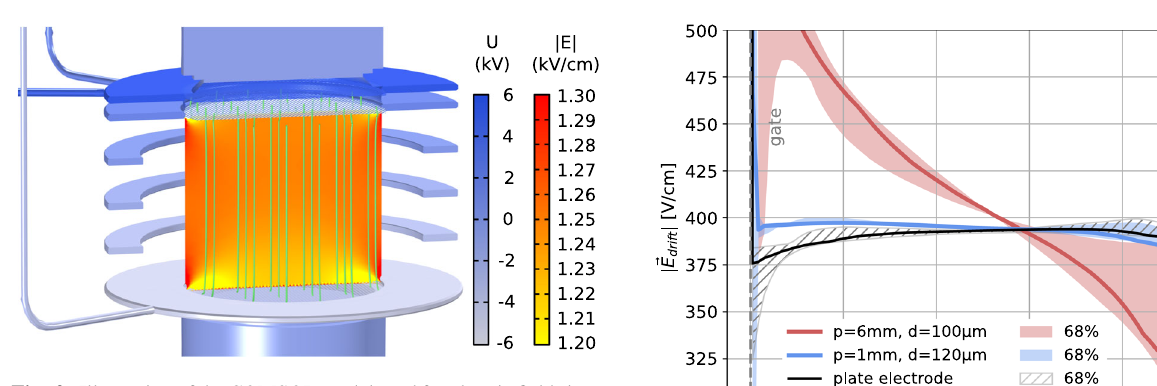
Fig. 2 Illustration of the COMSOL model used for electric field simu- lation. Shown is the outcome for an average field of 1.25kV/cm. While the blue color scale represents the potential at the metallic surfaces, the orange scale shows the field intensity across a plane through the central region. Several selected electric field lines are illustrated in green Fig. 3 Electric field as function of depth ( z -coordinate) in the TPC for different simulated values of wire thickness and pitch, in comparison to ideal plate electrodes (black